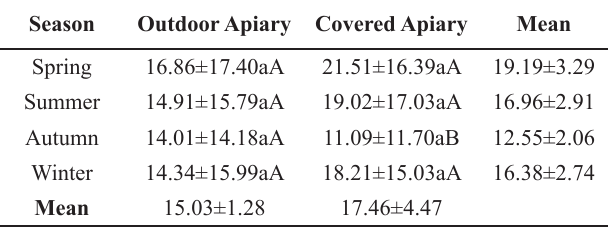
Table 3 . Intensity of natural infection of Nosema ceranae (average number of spores/bee x10 5 ) in hives located in open air and covered apiaries from August 2013 to August 2016 in relation to the seasons of the year.